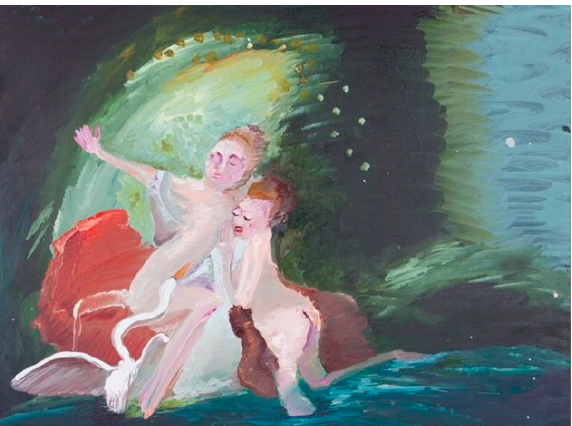
Figure 8. Acrylic on canvas of Leda and the Swan (after Boucher), 2018, © Genieve Figgis.